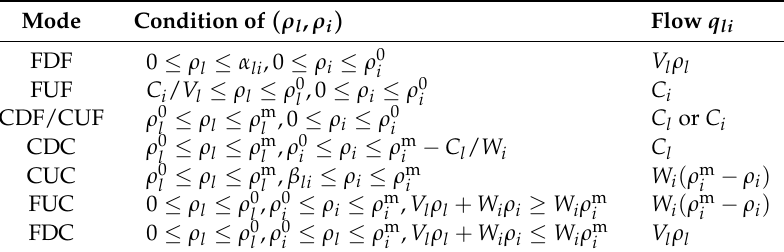
Table 1. Modes of i with relation to upstream l